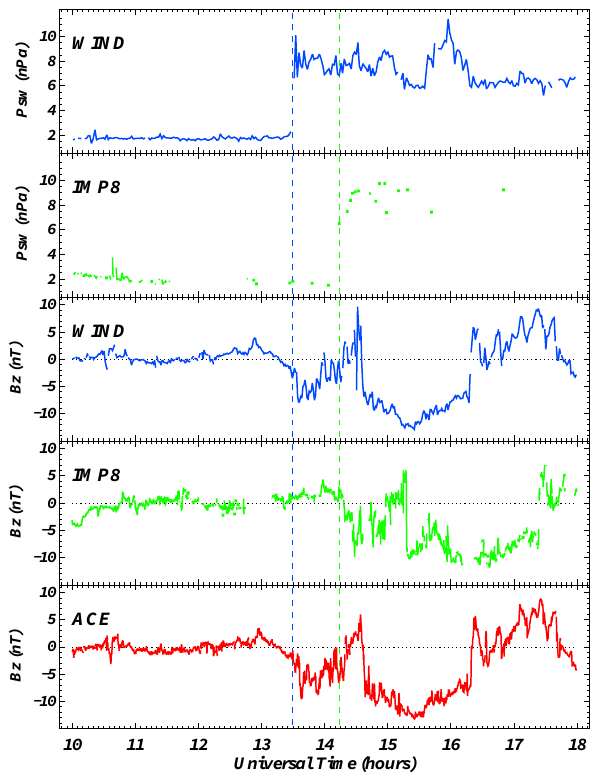
Fig. 2. Solar wind conditions for 6 January 1998. The top two panels show the solar wind dynamic pressure observed by WIND and IMP8, while the three bottom panels show the IMF B z com- ponent in GSE coordinates measured by WIND, IMP8, and ACE. The three spacecraft were located at X GSE ∼ 227 R E , X GSE ∼ 30 R E , and X GSE ∼ 220 R E , for WIND, IMP8, and ACE, respectively. The vertical lines mark the times when WIND (blue) and IMP8 (green) encountered the pressure front. The pressure front impacted the magnetosphere at ∼ 14:25